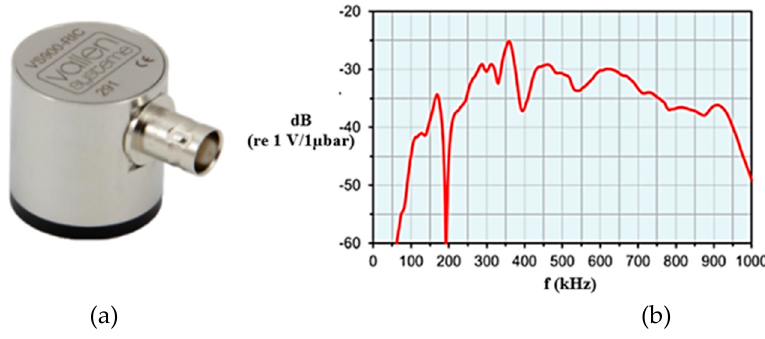
Figure 4. ( a ) VS-900 AE sensor; ( b ) frequency sensitivity spectrum of the VS-900 AE sensor. Figure 4. (a) VS-900 AE sensor, (b) frequency sensitivity spectrum of the VS-900 AE sensor. 2019 , 9 , x; doi: FOR PEER REVIEW Table 1. Threshold for each channel.